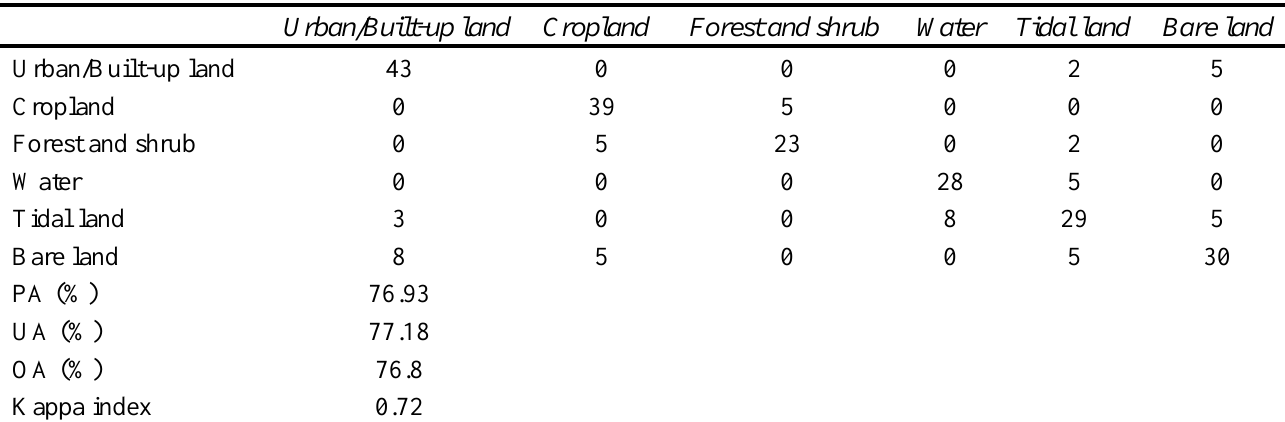
Table 2. 1987 accuracy assessment of land use classification (Kappa index and overall accuracy).